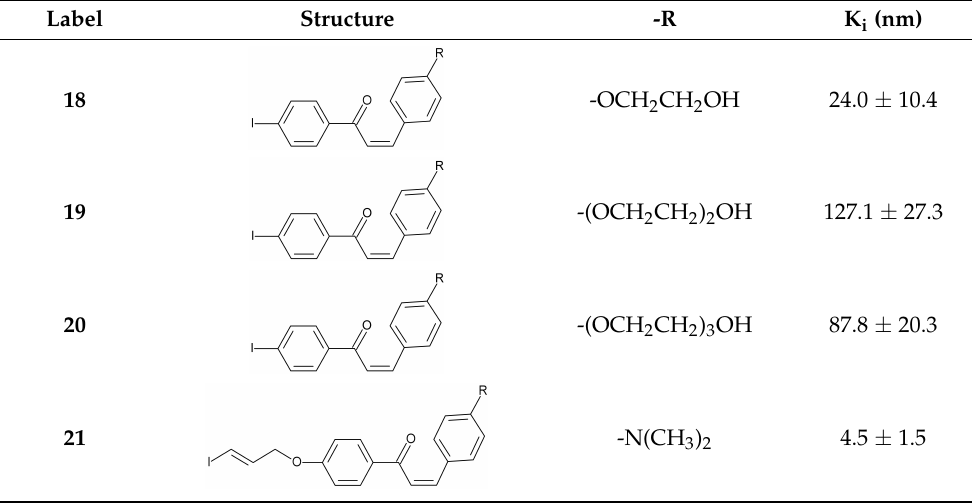
Table 3. Inhibition constants of ethyleneoxy-iodochalcone and iodoallyloxy-chalcone derivatives